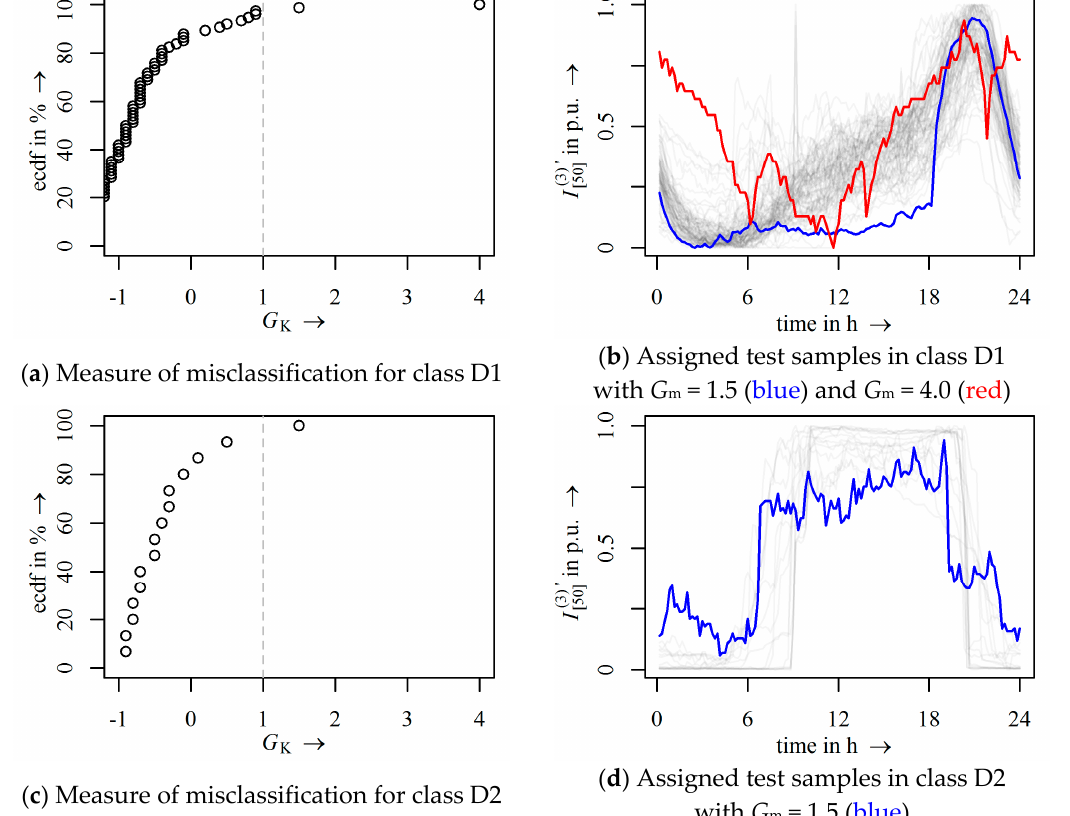
Figure 11. Measures of misclassification for the classes D1 and D2, and emission profiles of training samples (grey), and test samples (blue/red).